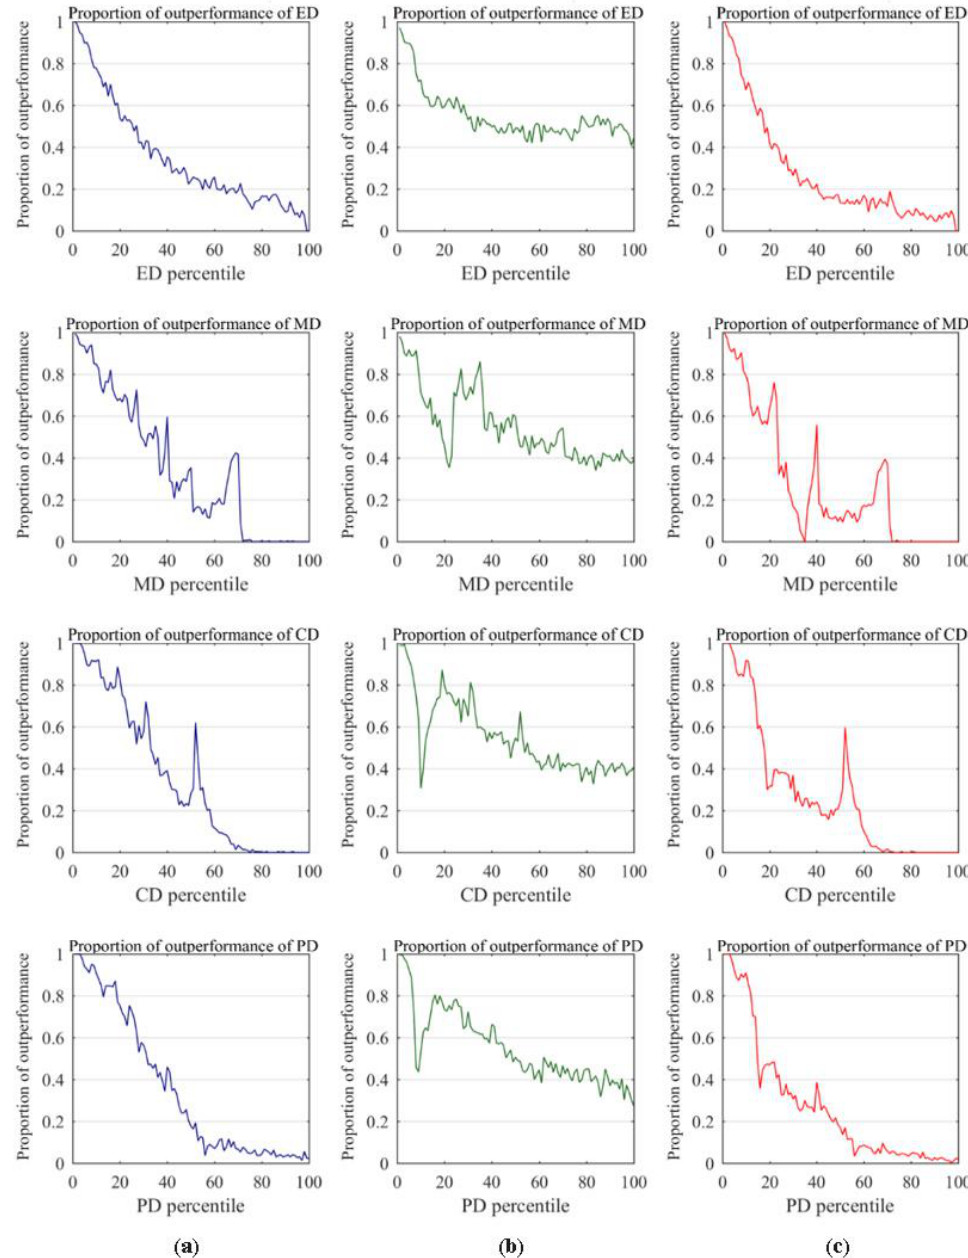
Figure 5. Changes in the proportions of outperformance to the 1/ N portfolio by distance percentile group. ( a ) Sharpe ratio; ( b ) rate of return; ( c ) risk.